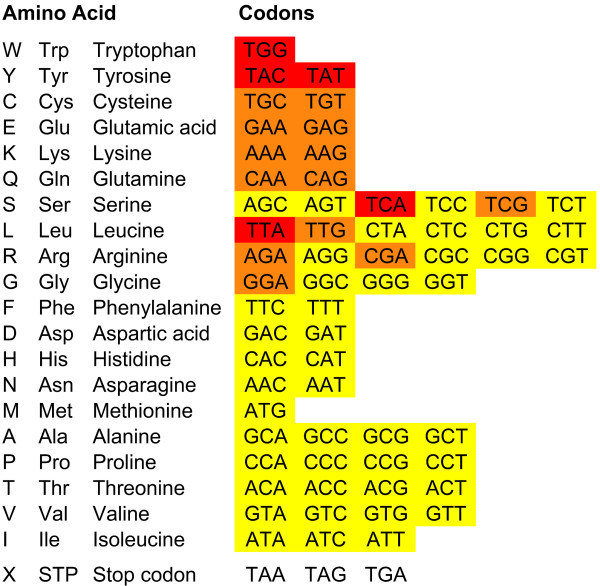
Genetic code and risk of acquiring nonsense mutations. The codons of the standard genetic code are listed along with the 20 amino acids and the three stop codons. A risk score ω is shown as ω = 0 (yellow), ω = 1 (orange), and ω = 2 (red). The list is sorted according to the mean risk of the codons encoding a specific amino acid.